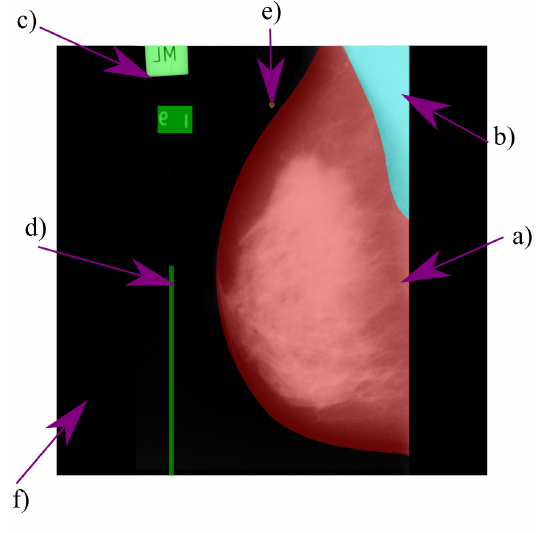
Figure 13. Typical components of a digitized mammogram: ( a ) breast region, ( b ) pectoral muscle, ( c ) medical label, ( d ) digitization artifact, ( e ) salt noise, and ( f )